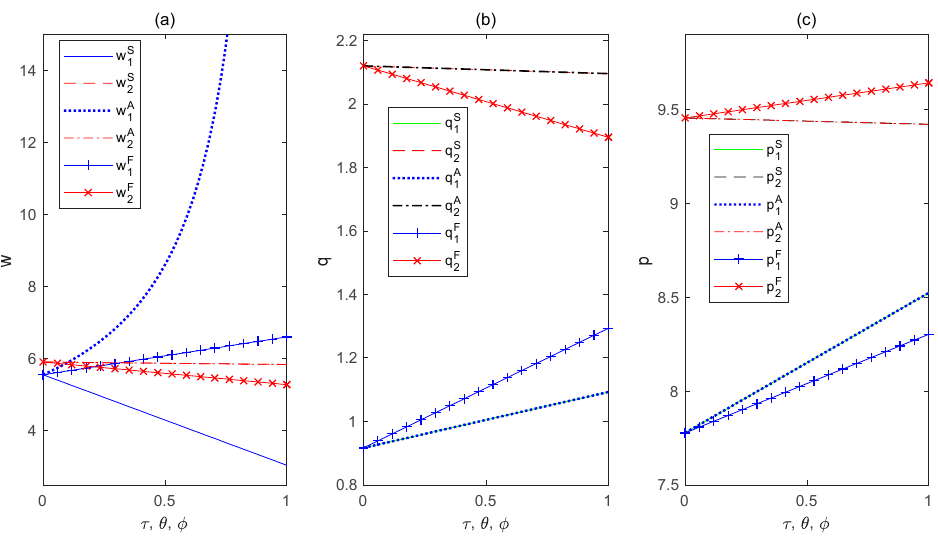
Figure 2. ( a ) Effects of the retailer’s CSR practices on w 1 and w 2 . ( b ) Effects of the retailer’s CSR practices on q 1 and q 2 . ( c ) Effects of the retailer’s CSR practices on p 1 and p 2 .